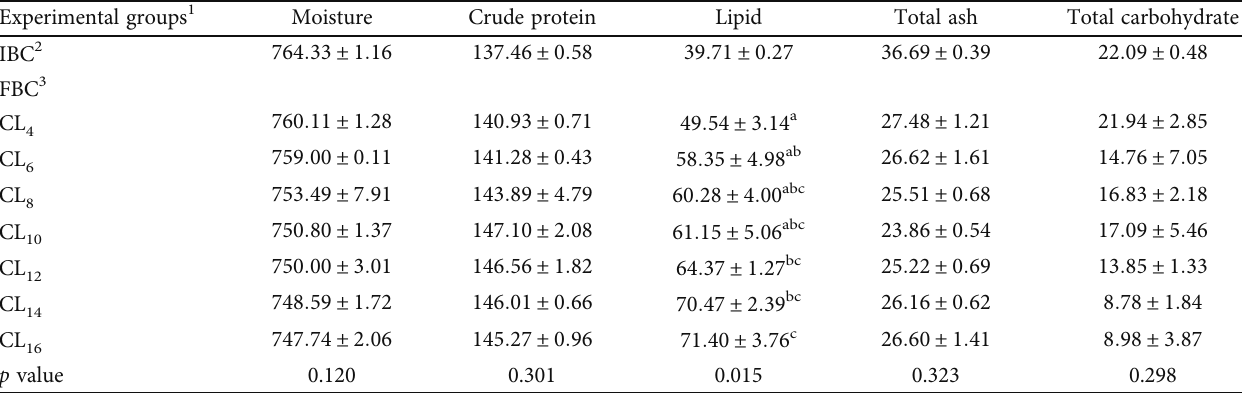
Table 3: Whole body proximate composition (on g/kg wet weight basis) of GIFT juveniles cultured in IGSW of 15 ppt and fed with experimental diets for 60 days.